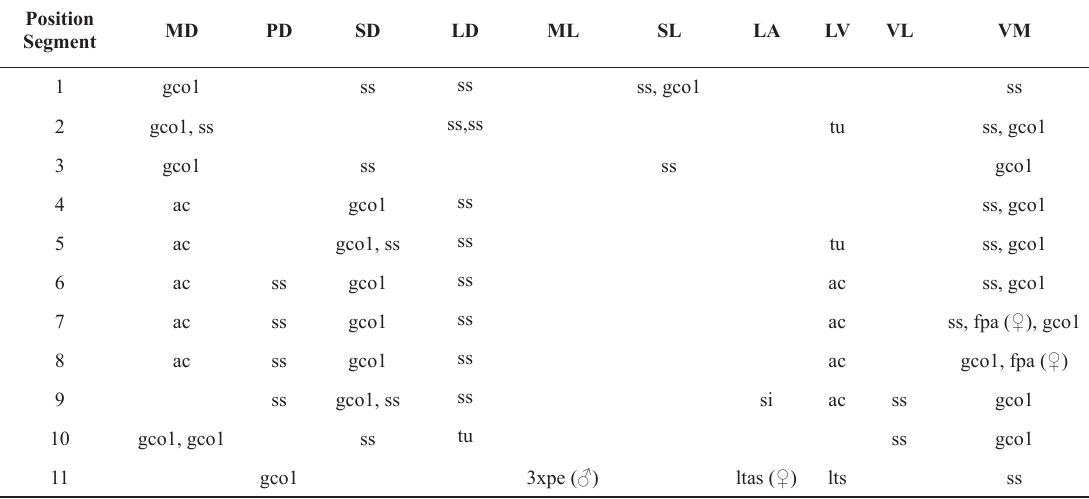
Table 13. Summary of nature and location of sensory spots, glandular cell outlets, tubes and spines arranged by series in Echinoderes worthingi Zelinka,